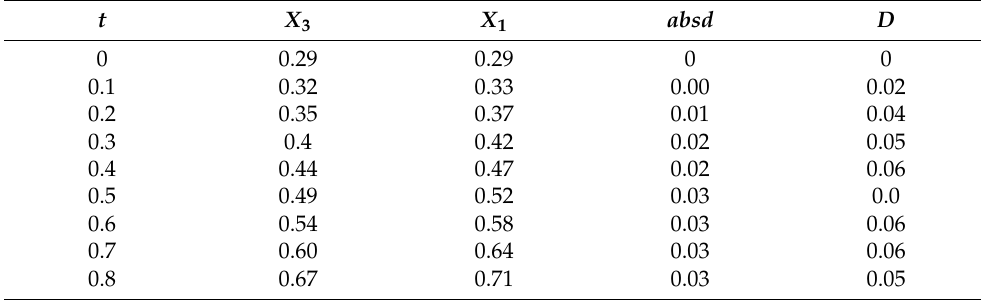
Table 5. Comparison of solutions the resulting by the ODE 1 and ODE